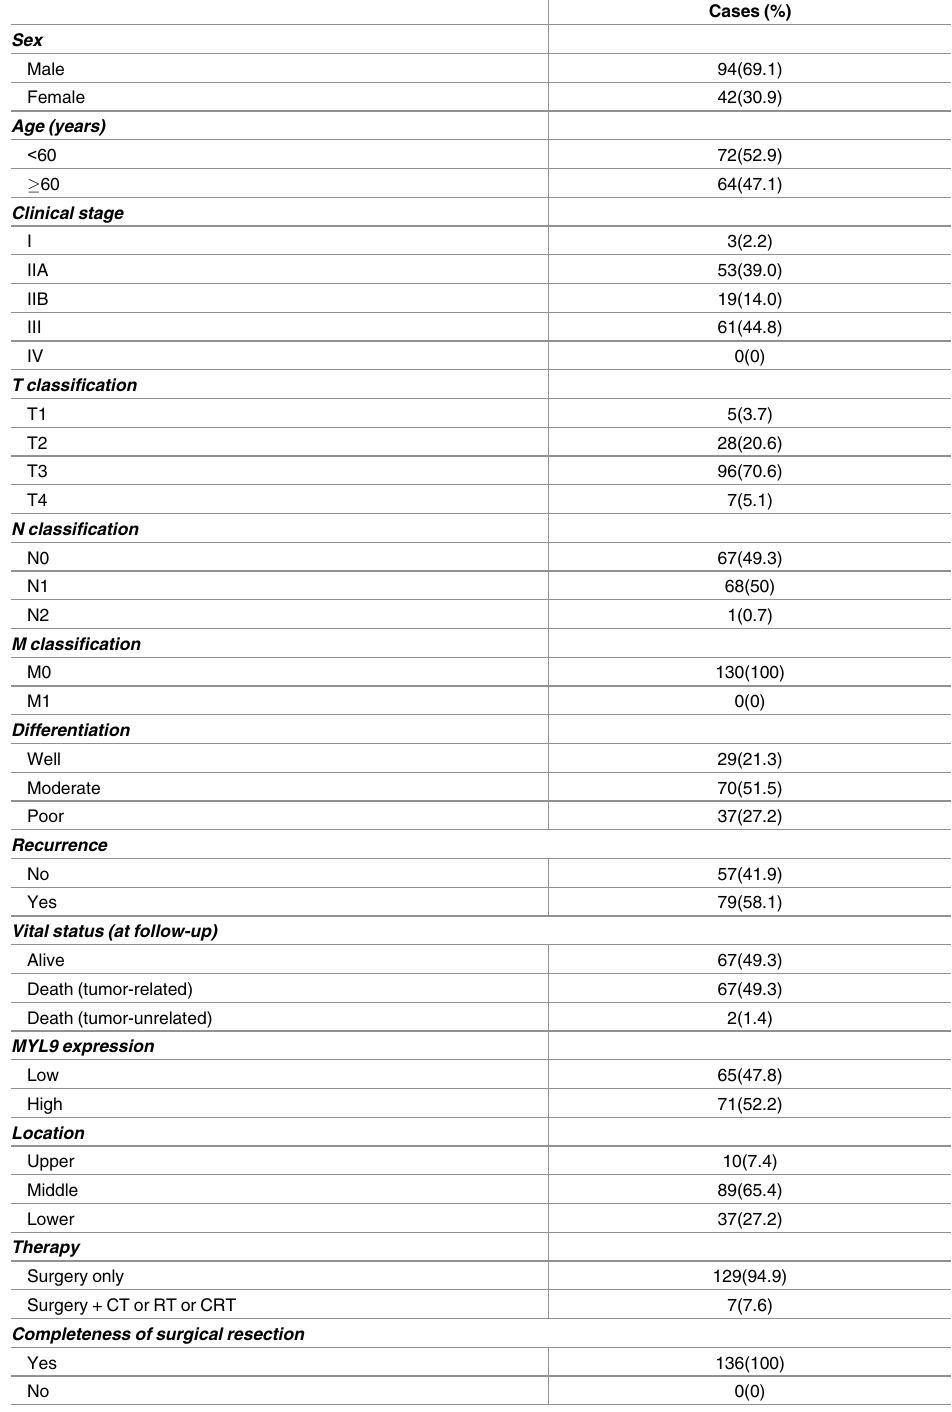
Table 1. Patient clinicopathological characteristics and MYL9 expression in